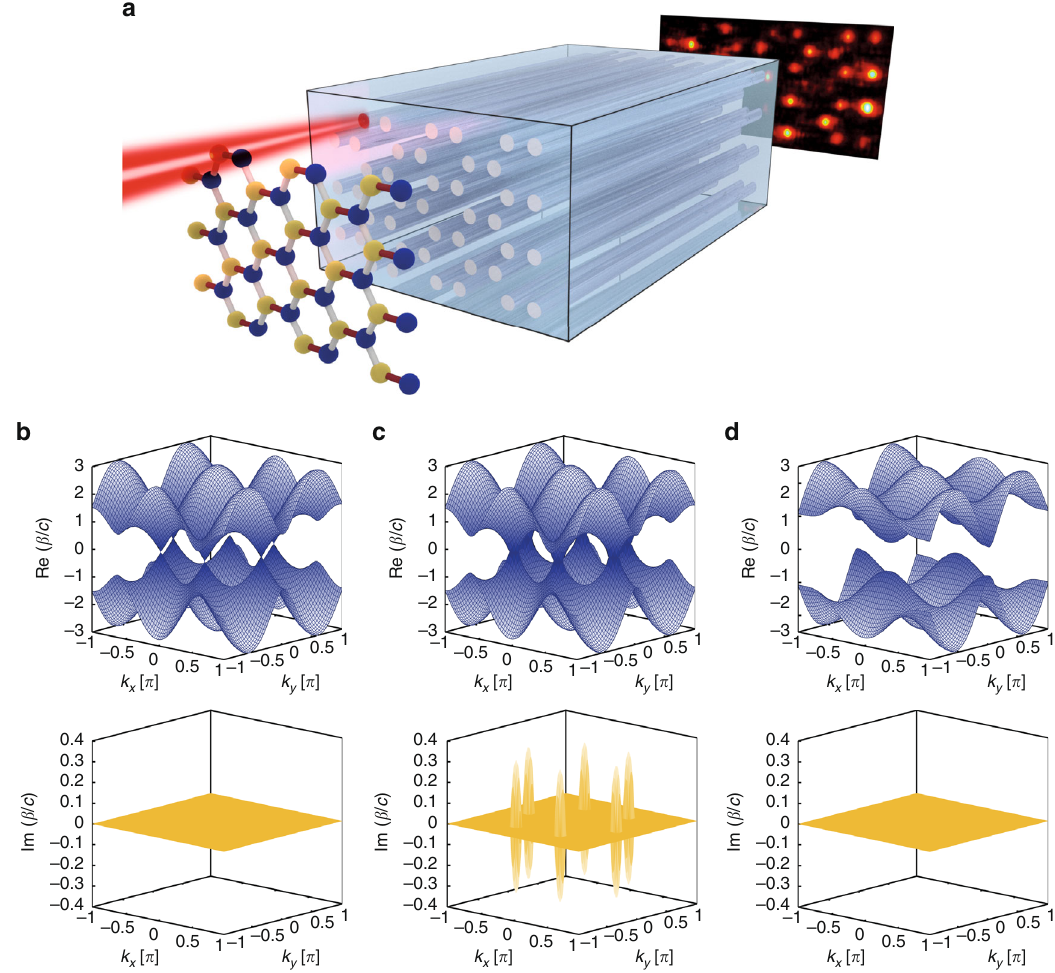
Fig. 1 The PT -symmetric graphene lattice. a Due to the quantum-optical analogy between solids and waveguide lattices, the probability amplitude of a single electron in a carbon graphene lattice shares the same evolution equation as a light beam injected into a honeycomb waveguide lattice. b The dispersion relation of a graphene lattice with no gain/loss and no strain ( τ = 1), c with gain/loss and no strain ( τ = 1), and d with gain/loss above the critical point ( τ > 2 þ γ c ), which corresponds to the unbroken PT -symmetry